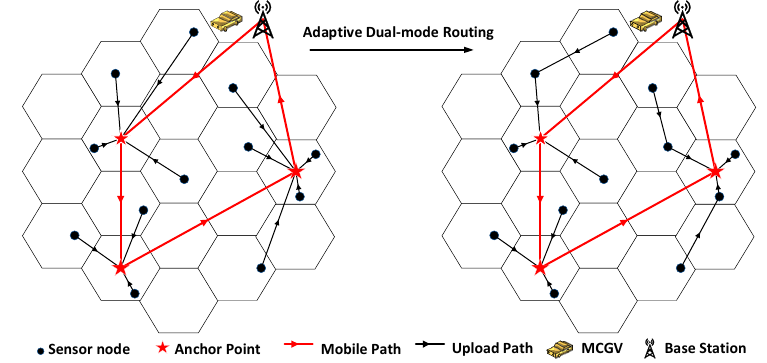
Figure 2. Operation principle of adaptive dual-mode routing.